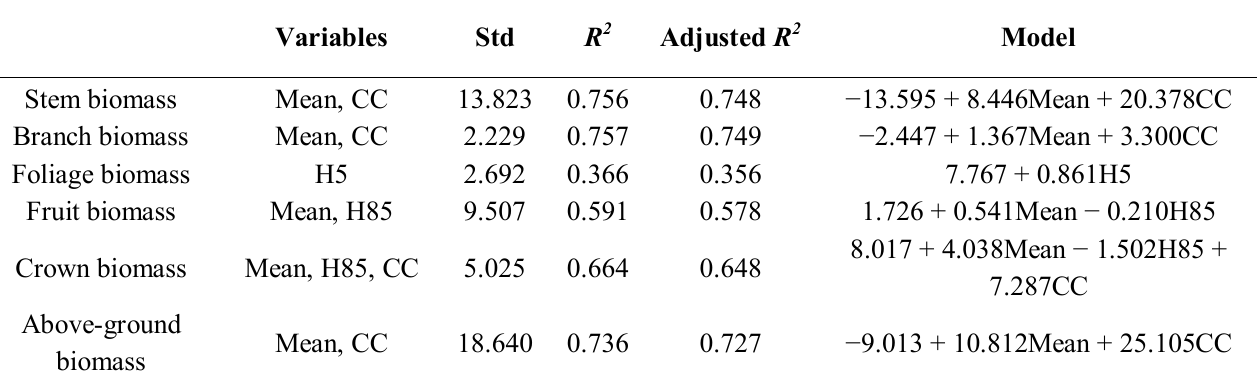
Table 2. Stepwise multiple regression results for above-ground biomass and individual biomass